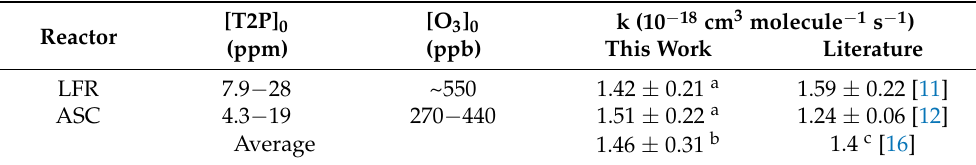
Table 1. Experimental conditions and obtained rate coefficients for the ozonolysis of T2P in LFR and ASC reactors at 298 ± 2